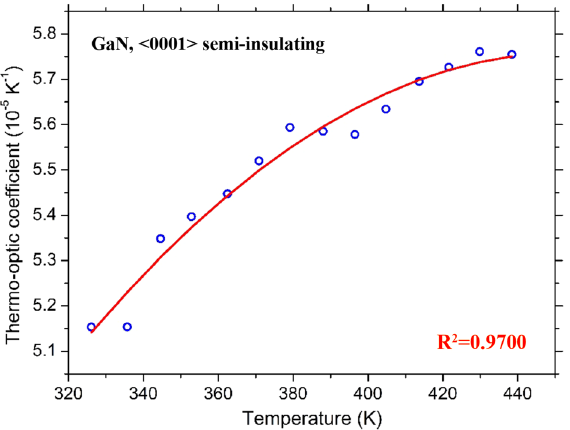
Figure 5. Thermo-optic coefficient as a function of temperature for the GaN sample.